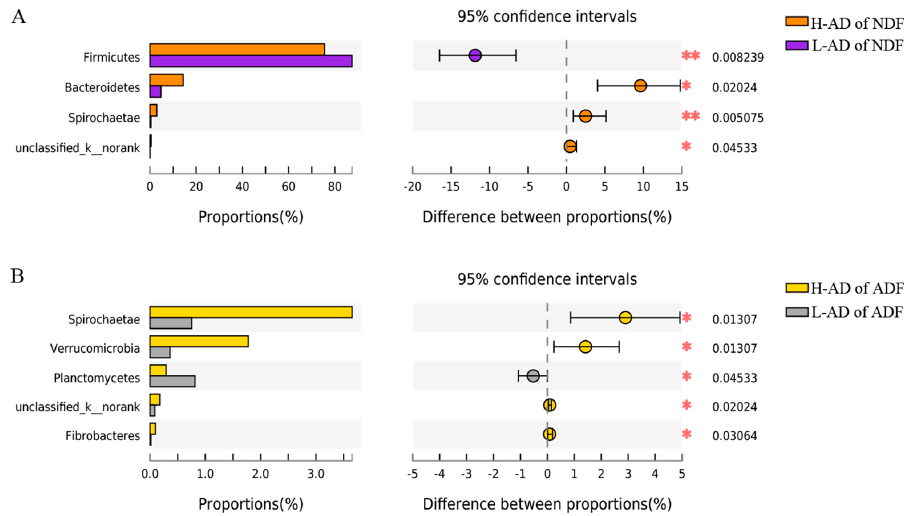
Figure 1. The bacterial abundances of distinct phyla significantly different between H- and L-AD of NDF ( A ) and ADF ( B ). Extended error bar plot showing phyla that had significant differences between H- and L-AD of NDF and ADF. Positive differences in mean relative abundance indicate phyla overrepresented on H-AD of NDF and ADF, while negative differences indicate greater abundance in L-AD of NDF and ADF. * The mean difference is significant at a level of 0.05, ** The mean difference is significant at a level of 0.01.